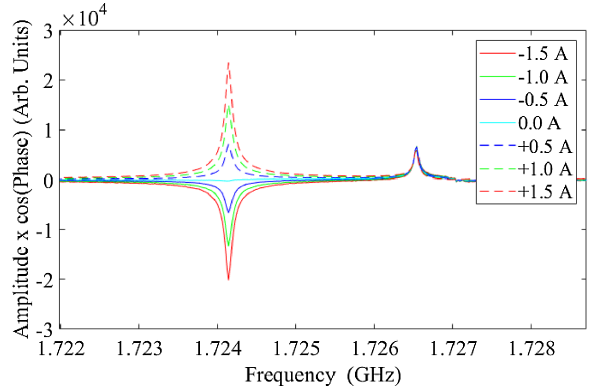
FIG. 16. “ Signed ” spectra of ∼ 1 . 72 GHz mode showing the V125 vertical corrector steering effects on the dipolar mode 7 amplitude in C1. The reference 0.0-A setting is confirmed with the low mode amplitude observed in this and for other dipolar modes.